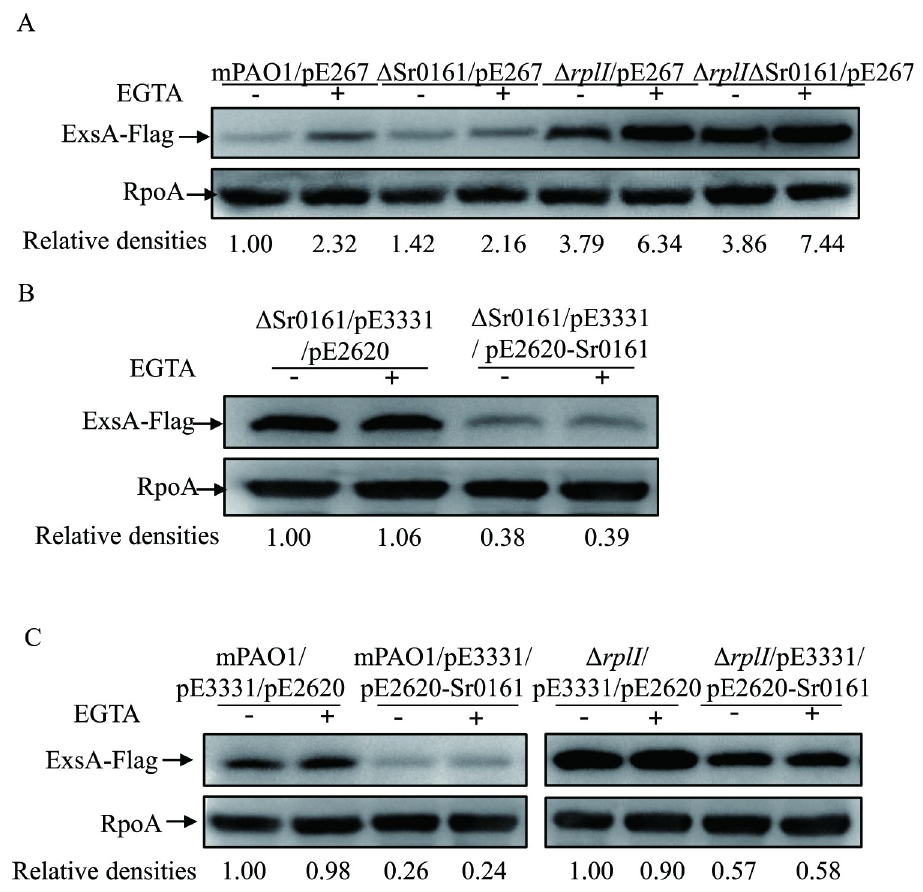
Fig 6. Sr0161 is not involved in the RplI mediated control of ExsA translation. The protein levels of ExsA-Flag in mPAO1, Δ Sr0161, Δ rplI and Δ rplI Δ Sr0161 containing pE267 (A); Δ Sr0161 containing pE3331 and empty vector (pE2620) or pE2620-Sr0161 (B); mPAO1 and Δ rplI containing pE3331 and empty vector (pE2620) or pE2620-Sr0161 (C). Bacteria cultured overnight were diluted 1:50 into LB medium with 1 mM IPTG (B and C) or without IPTG (A), grown to an OD 600 of 1.0 with (+) or without (-) 5 mM EGTA, and collected by centrifugation. Samples from equivalent numbers of bacterial cells were separated by SDS-PAGE and probed with an anti-Flag or an anti-RpoA antibody. The density of each band was determined with Image J. Relative densities represent the density of ExsA-Flag/ density of RpoA with the respective first lane as 1. The data shown represent the results from three independent